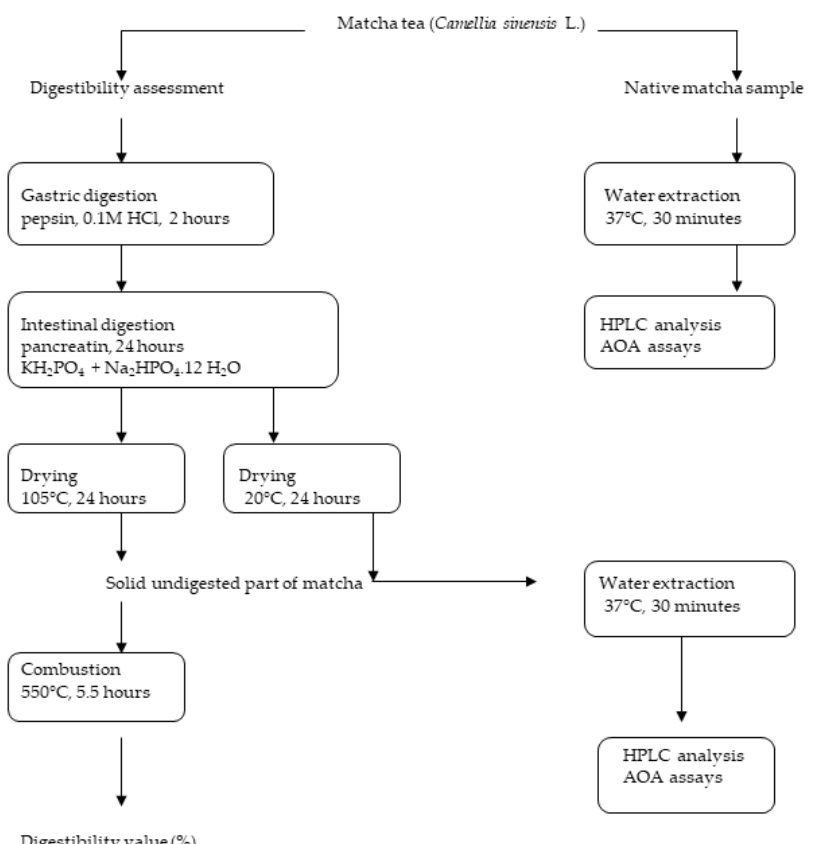
Figure 1. Scheme of in vitro digestion procedure. AOA—antioxidant activity assays.